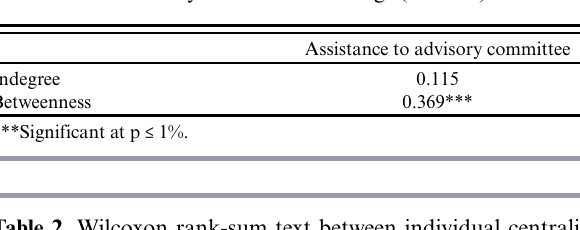
Table 1 . Spearman correlations between individual centrality and assistance to advisory committee meetings (n = 198).